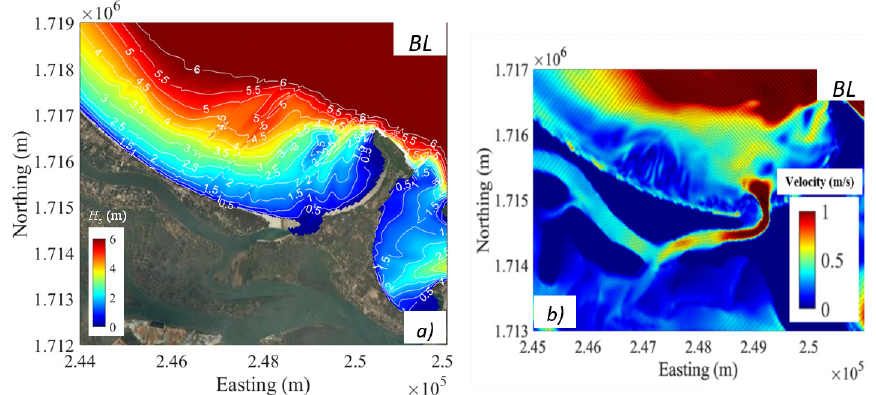
Figure 15. ( a ) Wave field, ( b ) current field under the impact of typhoon Molave—BL scenario.